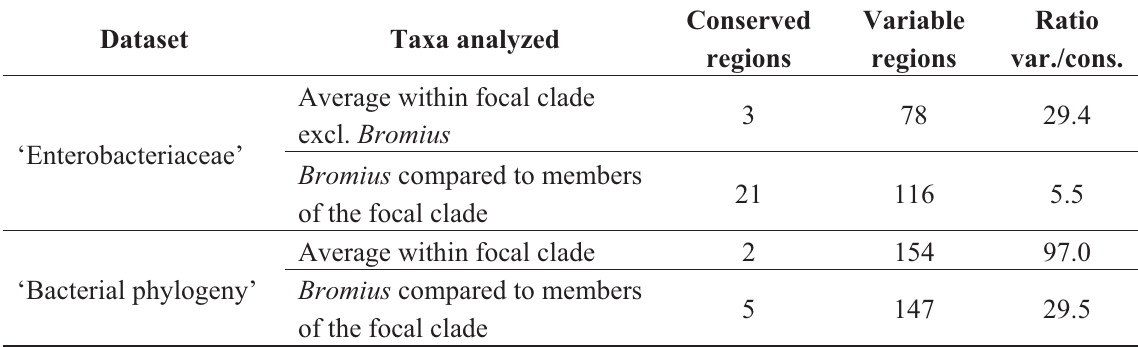
Table 4. Number of nucleotide substitutions in conserved vs. variable regions in sequences of Bromius (blind sacs) symbionts and members of the focal clade, and the ratio of the two values (variable/conserved). Numbers given are the mean number of substitutions found in pairwise comparisons. The datasets are explained in section 3.3. The ‘focal clade’ is a group of six sequences containing the symbionts of Donaciinae and a few others (see Figure 2 and 3), in the ‘Enterobacteriaceae’-dataset, the focal clade is more restricted (see Figure